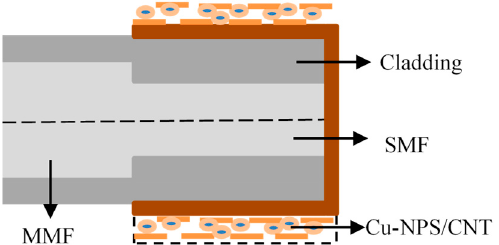
Figure 9. Structural diagram of the nitrate concentration sensor [91].